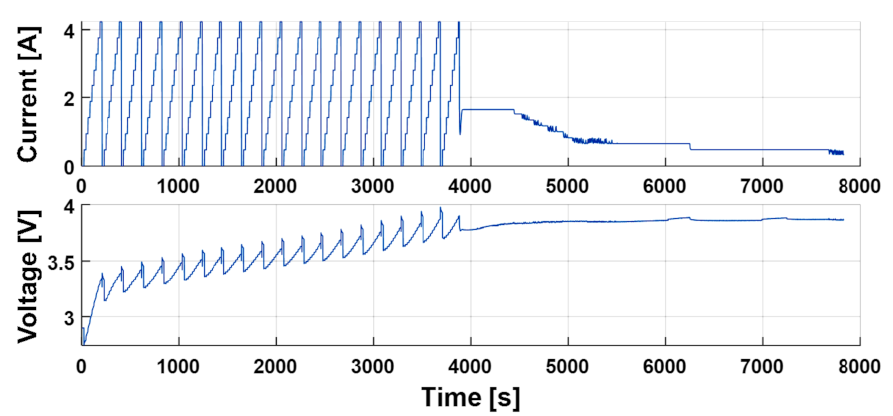
Figure 16. Sample of step charge current profile and the voltage used for model